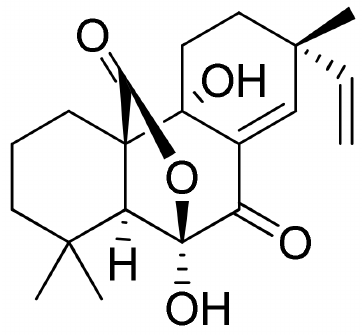
Figure 1. Structure of sphaeropsidin A